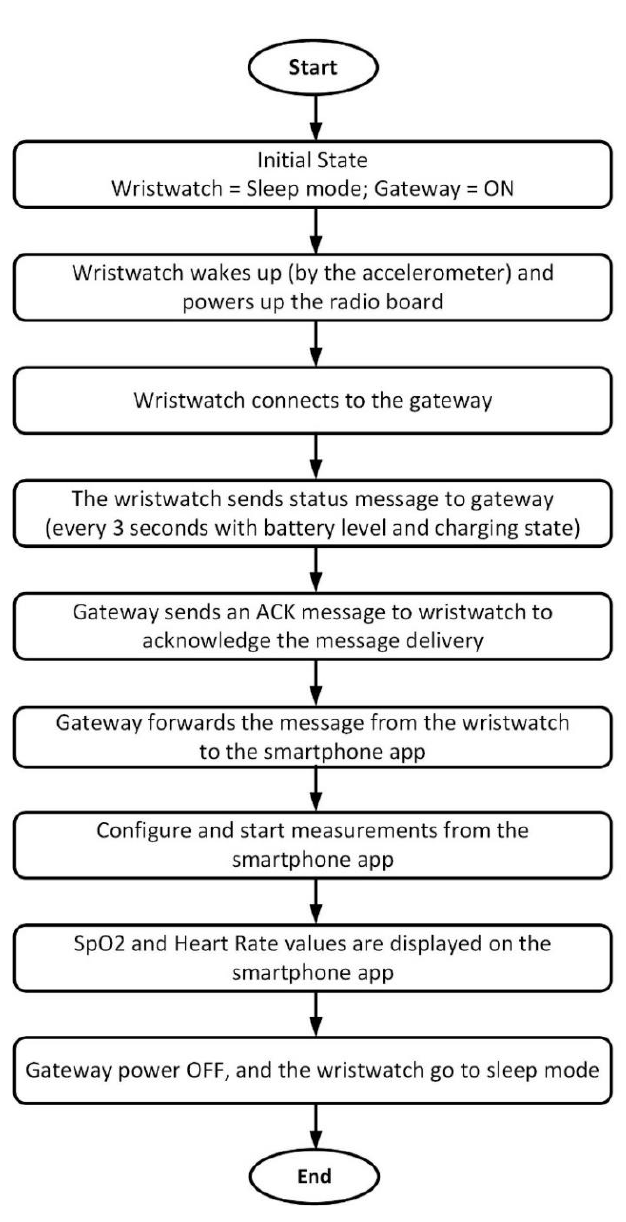
Figure 4. System workflow